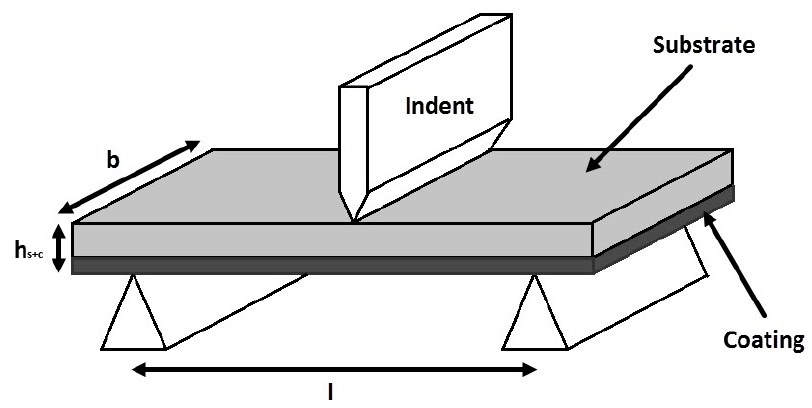
Figure 1. A 3D view of the three-point bending test set up.